Question: Write a single sentence explaining what this figure depicts.
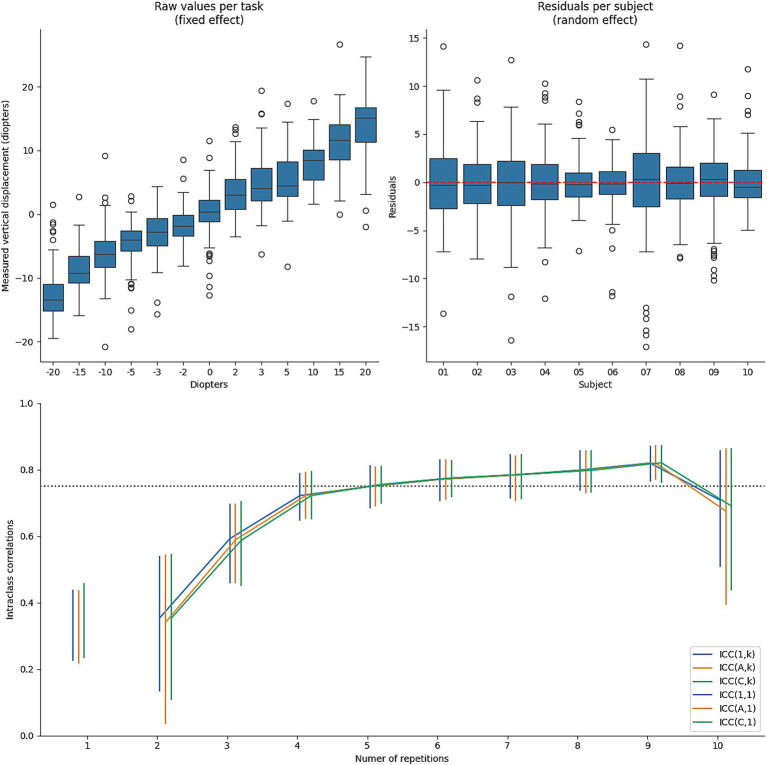
Answer: Linear mixed effects model measuring the effect of the induced skew on the measured eye vertical displacement. Top row, left panel: Measure of the main effect. Right panel: model residuals for each individual subject (random effect). Bottom row: intraclass correlation analysis. The different colored traces represent the value of the different ICC(1/A/C, *) coefficients. The points at n = 1 show the reliability of individual measurements per subject ( ICC ( 1/A/C,1 )). The points for n > 1 indicate the reliability of averaging n repeated measures. The horizontal dotted line marks the 0.75 threshold generally considered an indicator of good reliability.